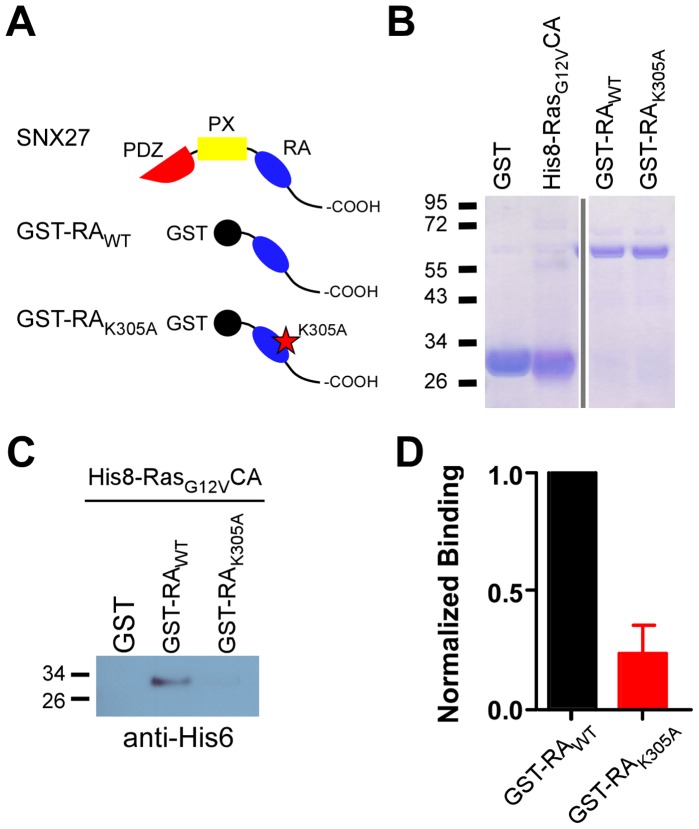
K305A point mutation in SNX27b RA domain disrupts interaction with constitutively active H-Ras (H-RasG12VCA).
A, Cartoons of SNX27b, GST fused to SNX27b-RAWT or SNX27b-RAK305A. B, Coomassie stain shows purified GST, His8-RasG12VCA, GST-RAWT and GST-RAK305A. C, Western blot using anti-His6 antibody shows His8-RasG12VCA binding to GST-RAWT but not to GST-RAK305A. C, Quantification of pull-down shows consistent decrease in association of GST-RAK305A mutant with His8-RasG12VCA (assay repeated 4 times).